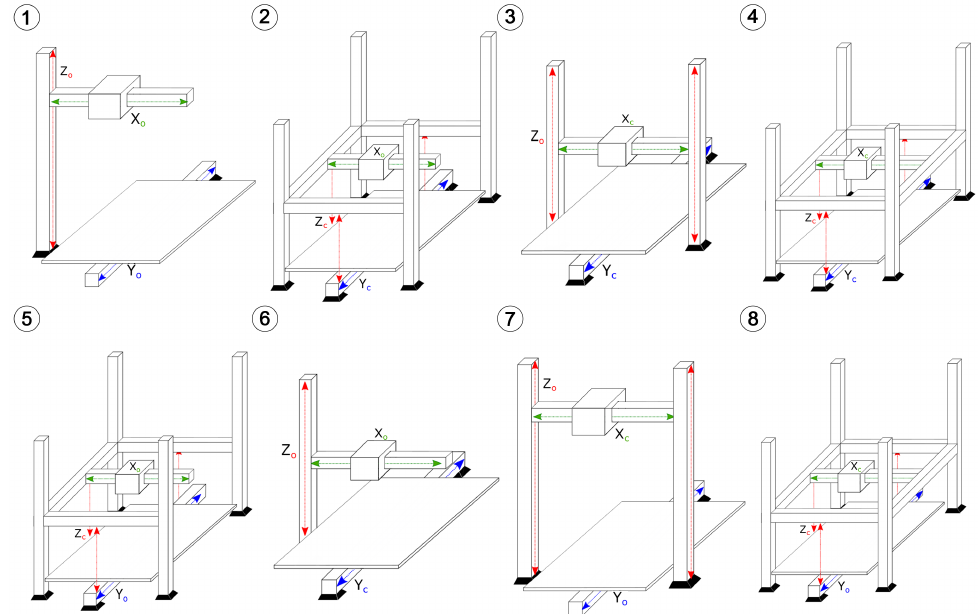
Figure A7. Fixed axes X B , Y H , Z B and actuated axes X H , Y B , Z H . Existing designs are 1 and